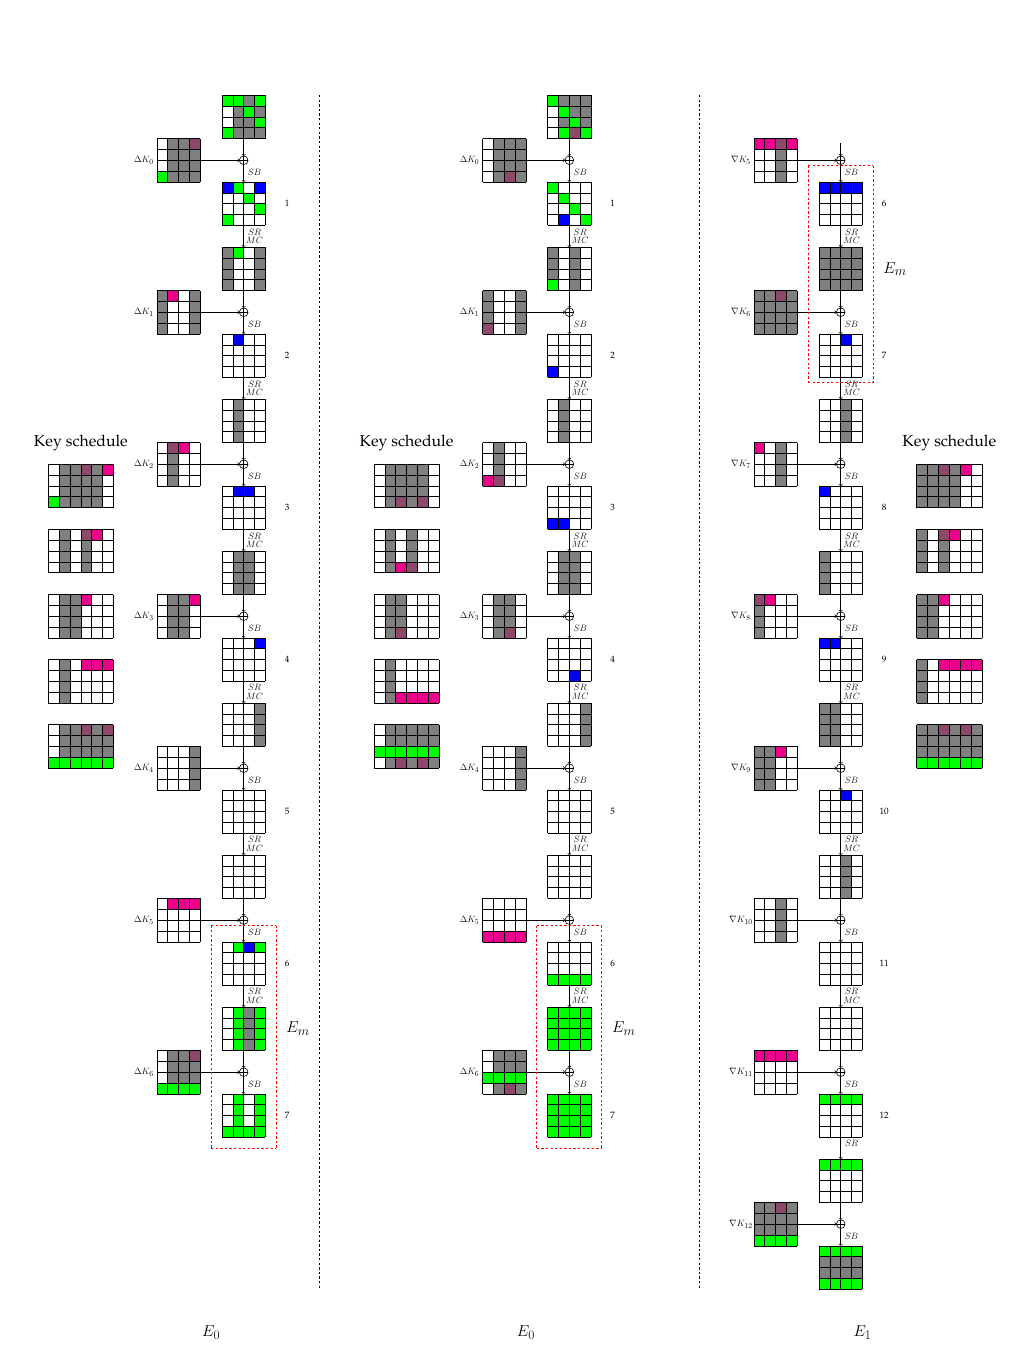
Figure 15: Two boomerang attacks on full-round AES -192. For E 0 , the left trail is the one used in [BK09] and is evaluated in Section 5.2, the middle trail is the one used in Section 5.1. Both attacks use the same trail for E 1 as shown on the right-hand side. The red rectangles depict the locations of 2-round boomerang